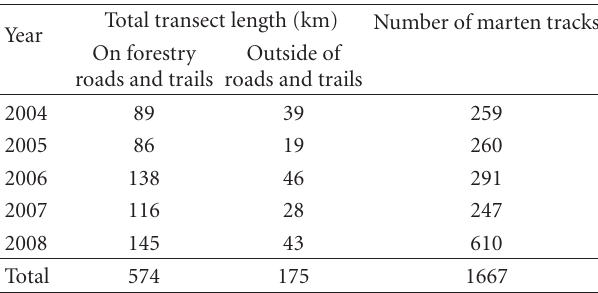
Table 3: Sampling e ff ort of snow-tracking from 2004 to